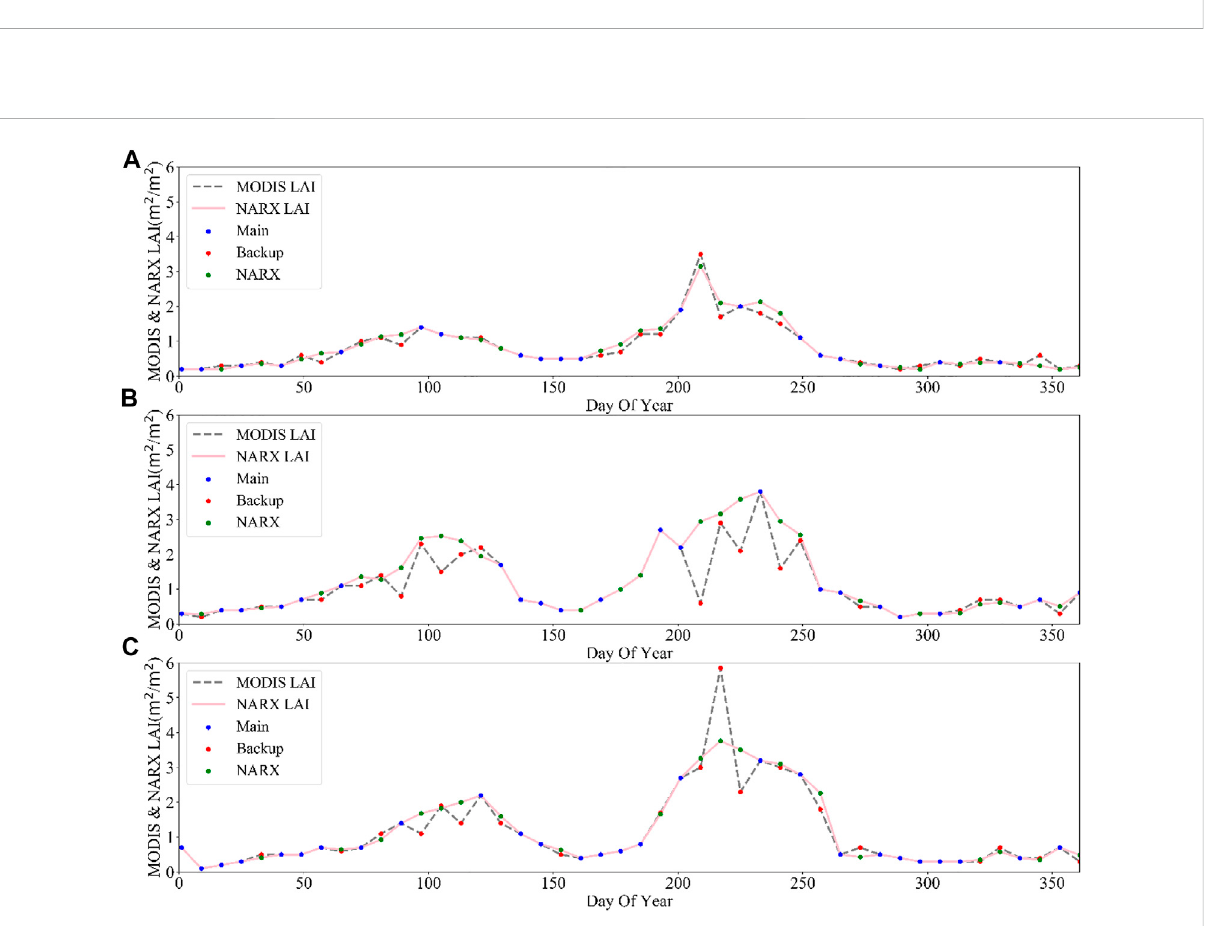
FIGURE 6 Comparison of the MODIS LAI product with NARX neural network-improved LAI data within the three study areas: (A) Wuzhi, (B) Xinzheng, and (C) Xiangcheng.